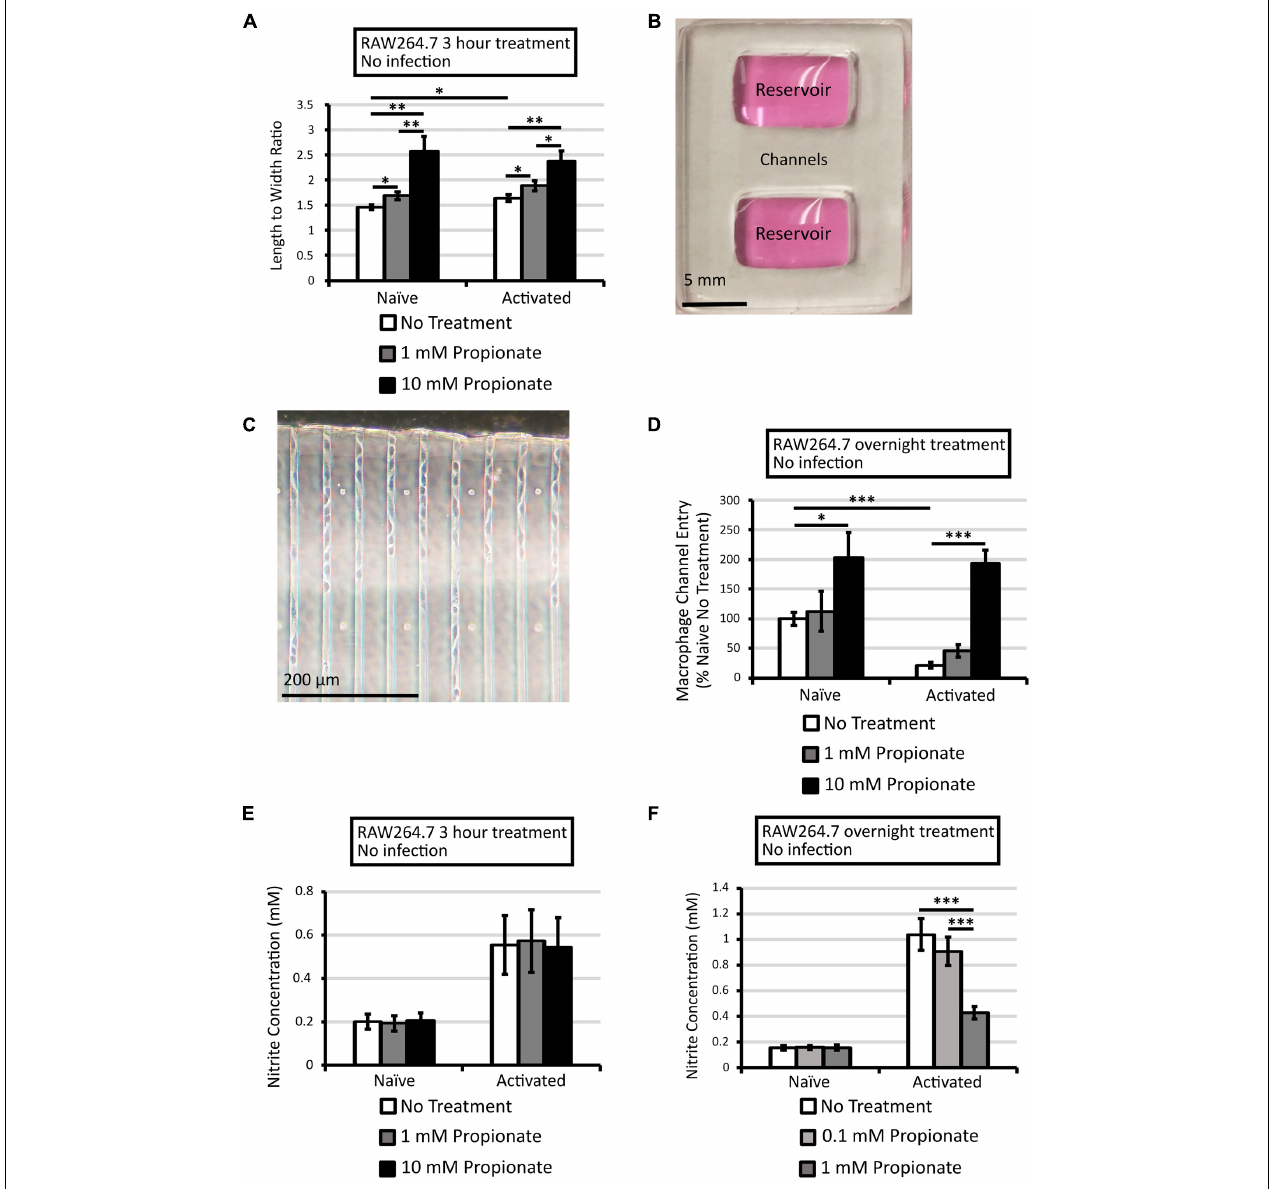
FIGURE 3 | Propionate treatment alters RAW264.7 activation status. To assess macrophage activation status, morphology and nitrite concentrations were measured for macrophages with or without activation by LPS and IFN γ . To assess morphology, microscopic images of macrophages with or without propionate treatment for 3 h were analyzed with ImageJ where cell length-to-width ratios of at least 20 cells across 2–4 independent experiments were calculated with error bars representing standard errors of the mean (A) . Additionally, entry into microfluidic channels was assessed using microfluidic devices that contain two reservoirs connected by channels with a cross section of 10 × 10 µ m (B,C) . RAW264.7 macrophages were seeded into a reservoir with or without activation and 0, 1, or 10 mM propionate and fixed after 21 h for image analysis. Averages of cell counts in channels up to 200 µ m from the entry point from two independent experiments (108 channels in total) were plotted with error bars representing standard errors of the mean (D) . Nitrite concentration was quantified for RAW264.7 macrophages treated with propionate for 3 h (E) or overnight (F) . Averages of 3 (E) and 4 (F) independent experiments, each performed in triplicate, were plotted with error bars representing standard errors of the mean. Asterisks denote statistical significance between pair-wise comparisons with ∗ p < 0.05, ∗∗ p < 0.01, and ∗∗∗ p <